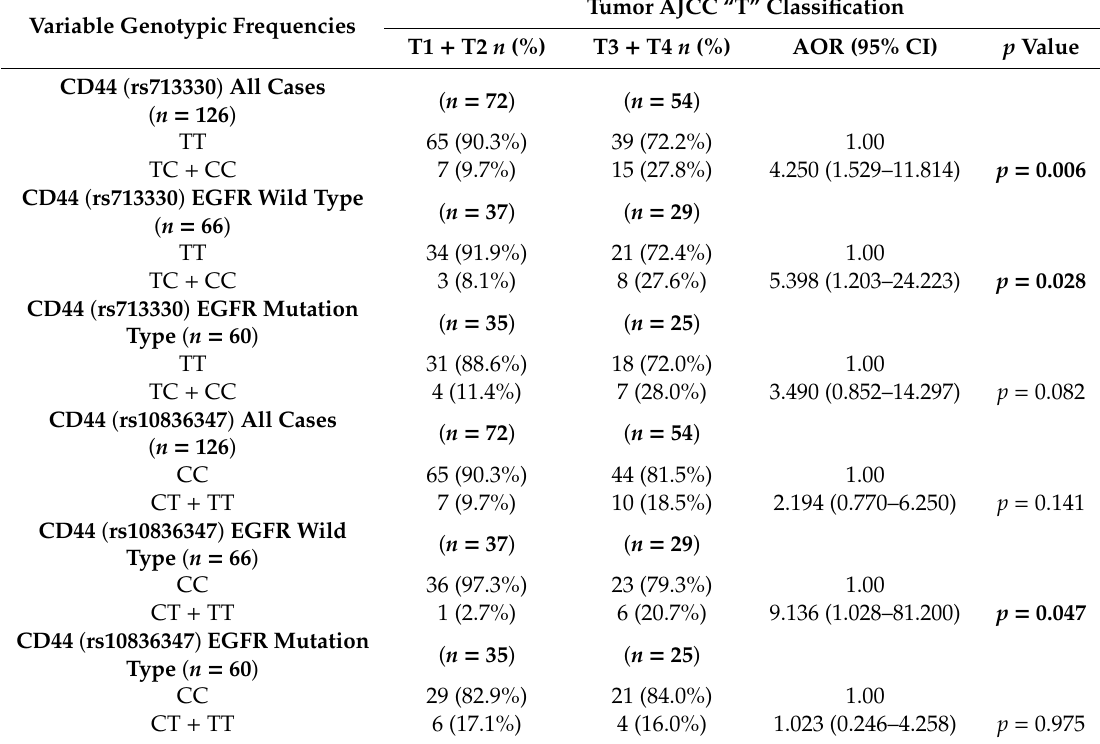
Table 4. The associations between polymorphic genotypes of CD 44 rs713330 and rs10836347 and clinicopathological characteristics of male patients with lung